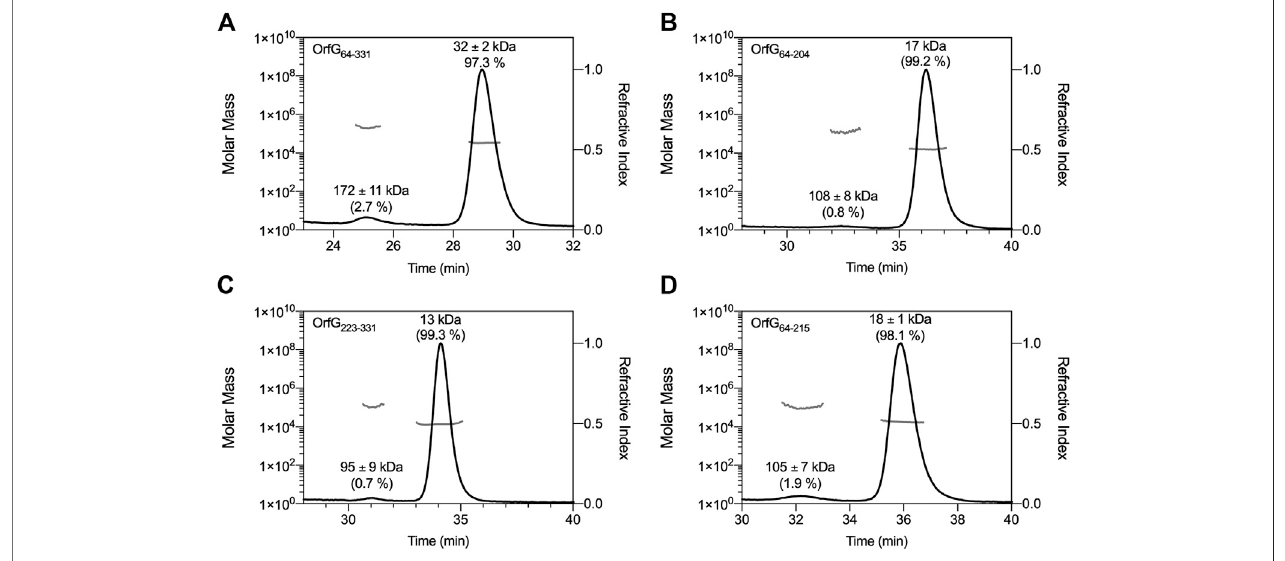
FIGURE 8 | SEC-MALS analysis. Elution pro fi le (black lines) of OrfG 64 – 331 (A) , OrfG 64 – 204 (B) , OrfG 223 – 331 (C) and OrfG 64 – 215 (D) are shown with the molecular weight calculated by MALS (gray lines). The elution time (min) is plotted on the x -axis. The molar mass (in logarithmic scale) is plotted in the fi rst y -axis and the refractive index is plotted in the second y -axis. The molecular weight (in kDa) and the contribution in mass fraction (in %) of each visible peak are shown at the top of the corresponding